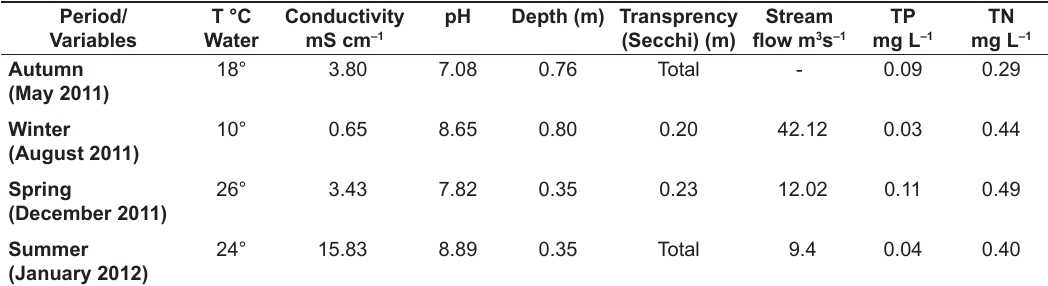
Table 3. Physical and chemical variables in Pseudônimo Stream during the study period (May 2011 to January 2012). Period/